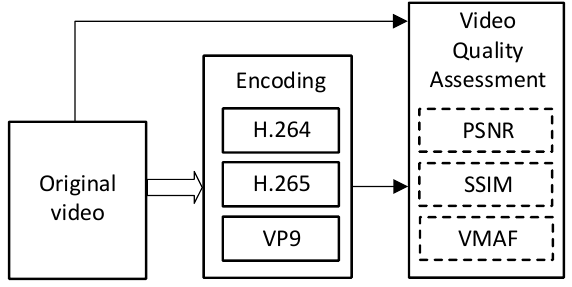
Figure 2. Video quality assessment using double stimulus method.